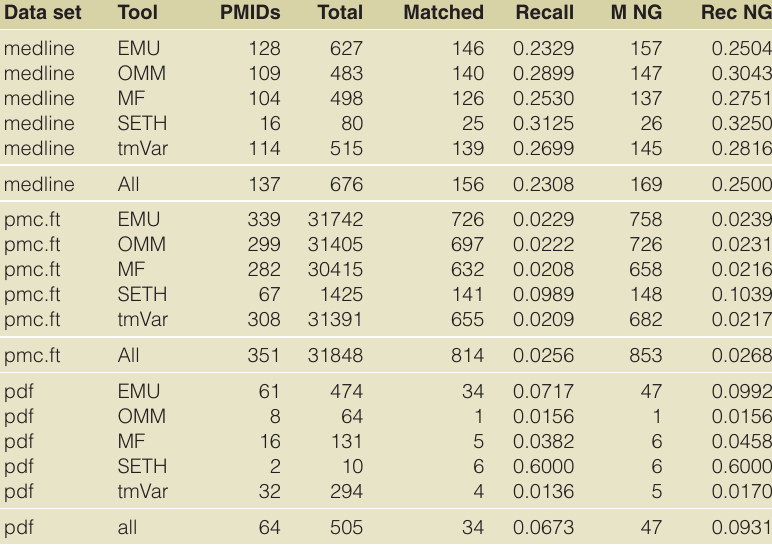
Table 10. COSMIC variant extraction coverage result when only articles with variants in the reference set as well as at least one result identified by the information extraction tool are considered. The table shows the number of common articles (PMIDs), the number of variants in the reference set (Total), the number of matched variants by the mutation extraction tool (Matched), the proportion of matched variants (Recall), the number of variants matched when the gene is not considered (M NG) and the proportion of matched variants when the gene is not considered (Rec NG). The data sets considered are MEDLINE abstracts (medline), Open Access PMC articles (pmc.ft), PDF articles when no Open Access PMC articles are available (pdf), PDF representation for all the articles (pdf.all), tables available from the Open Access PMC Articles’ XML (table), supplementary material (sup) and the combination from all the sources (all). The tools are Extractor of Mutations (EMU), OpenMutationMiner (OMM), MutationFinder (MF), tmVar and SNP Extraction Tool for Human Variations (SETH). The row with tool value as All indicates the result when the variants extracted by all the tools are